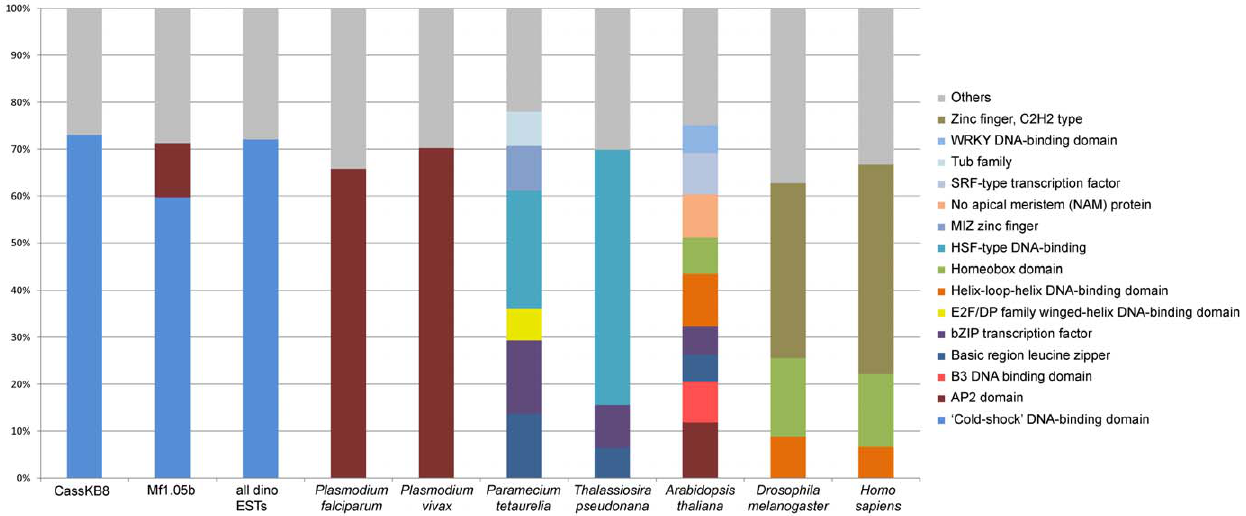
Figure 3. Transcription factor domain composition. The relative fraction of the most abundant transcription factor domains in the Symbiodinium transcriptomes, all dinoflagellate ESTs from the NCBI dbEST database, and other eukaryotes. Searches were performed by using HMMER to search domain models for DNA binding domains, with an e-value cutoff of , =1e 2 6. Domains which make up less than 5% were grouped in the ‘others’